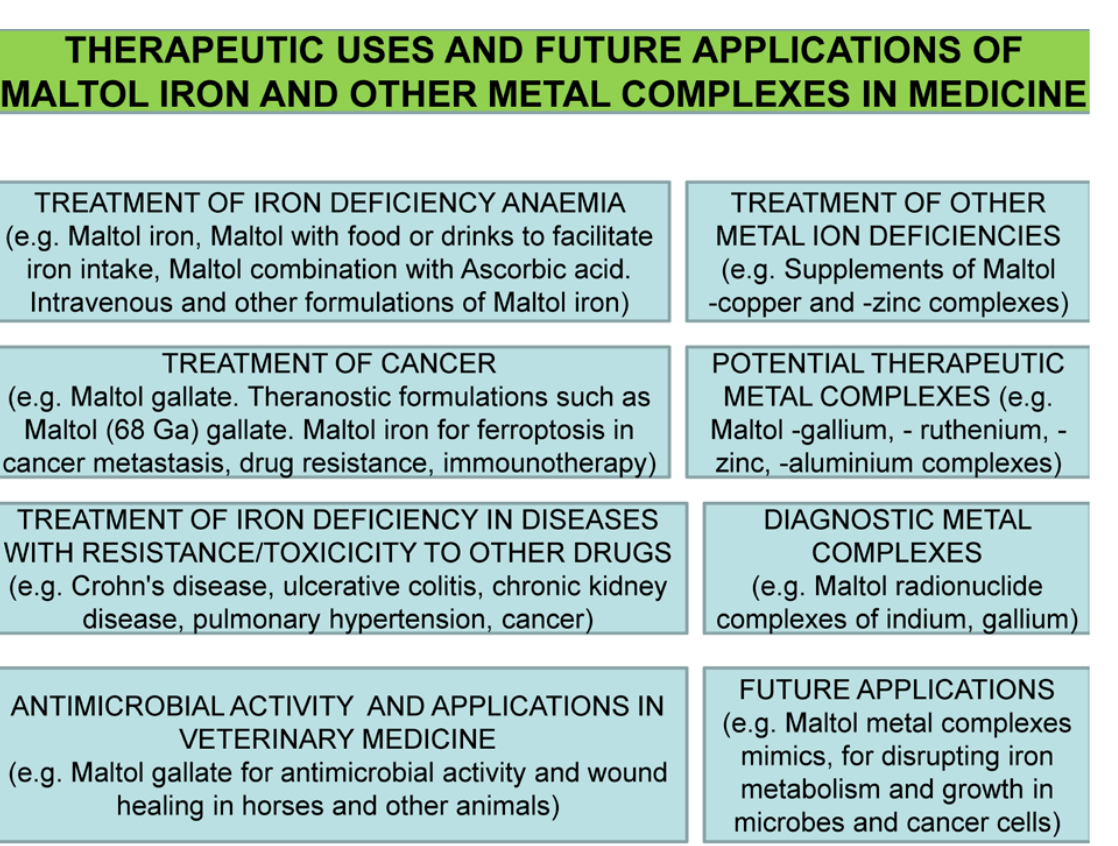
Figure 9. Ongoing therapeutic uses of maltol–iron in iron deficiency anemia and future applications of maltol–metal complexes in other fields of medicine. Many categories of patients may benefit from iron and other maltol–metal complexes. The wide range of therapeutic application prospects is related to the safety profile of the maltol–metal complexes.